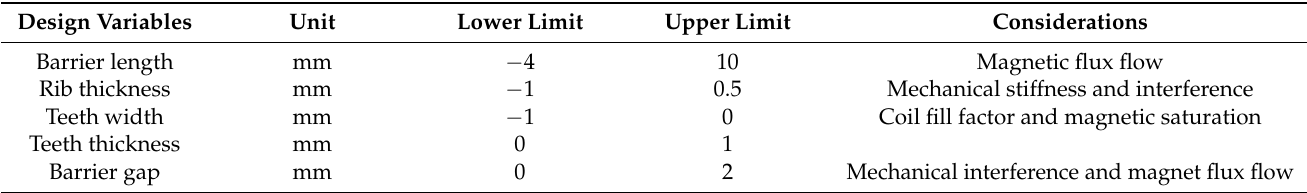
Table 2. Mechanical constraints of the design variables.